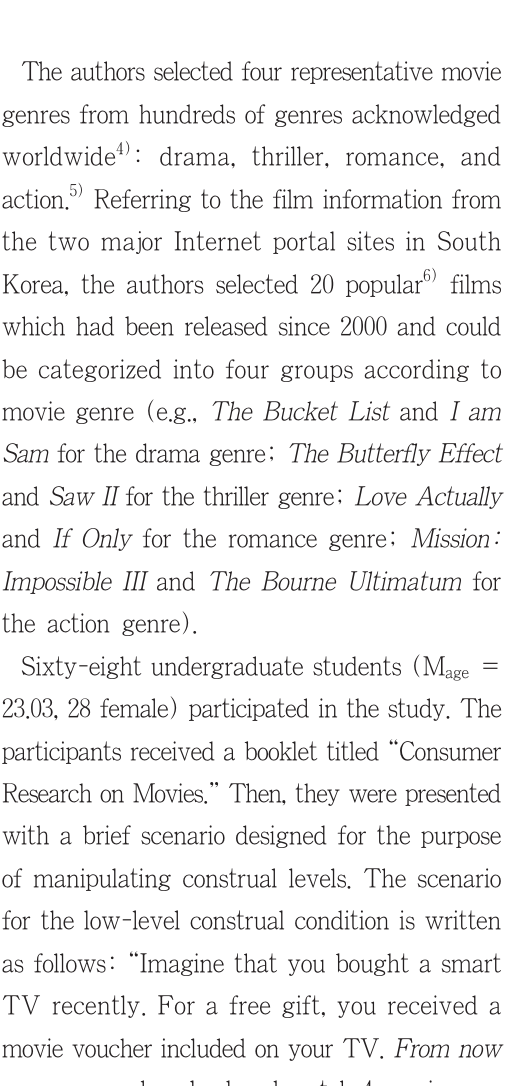
<Figure 1> The Effect of Construal Level